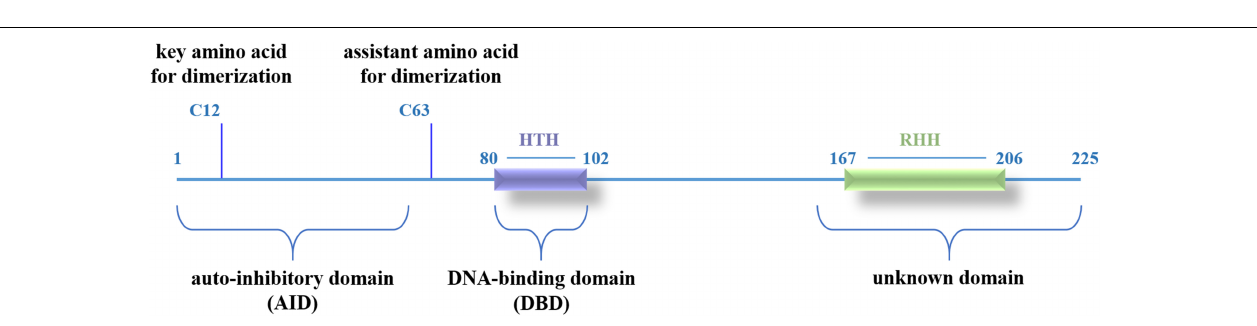
FIGURE 6 | Dimerization analysis of LmbU. (A) The LmbU protein was dealt with SDS, DTT, or was boiled for 5 min. − , not dealt with; + dealt with. (B) Dimerization analysis of LmbU variants LmbU113-225 and LmbU1-161. (C) Effect of C12 and C63 on LmbU dimer.